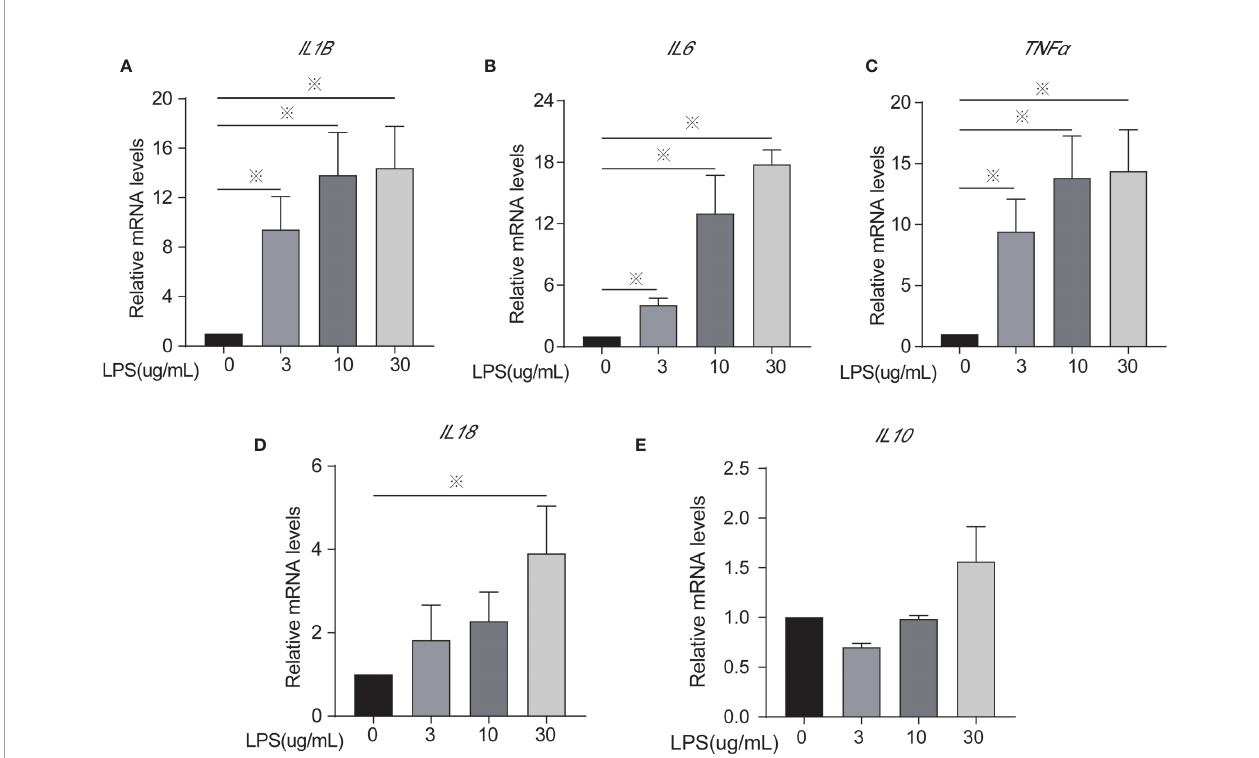
FIGURE 2 | In fl ammatory cytokines mRNA expression of cells treated with different concentrations of LPS for 24 h. (A) IL1 b , (B) IL6 , (C) TNF a , (D) IL18 , and (E) IL10 . Each treatment had three samples (n = 3) and was repeated three times to reduce system errors; “ ※ ” means there was a signi fi cant difference ( P < 0.05 ) compared with negative control (LPS, 0